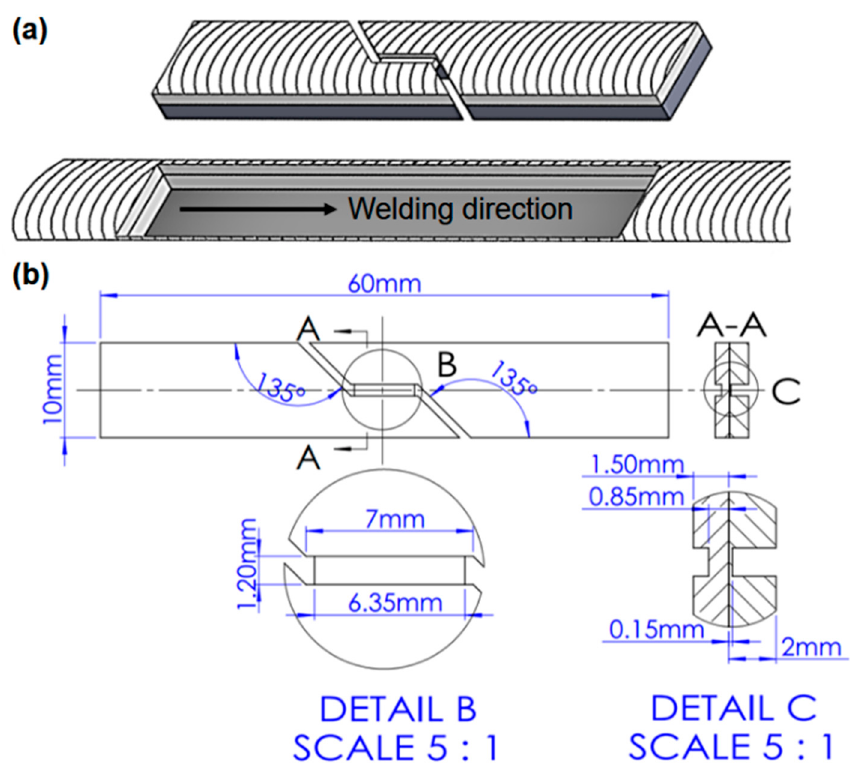
Figure 2. A shear test specimen with a volume fraction of 15% steel and 85% Al ( a ) schematic illustration of sampling location and ( b ) specimen geometry.